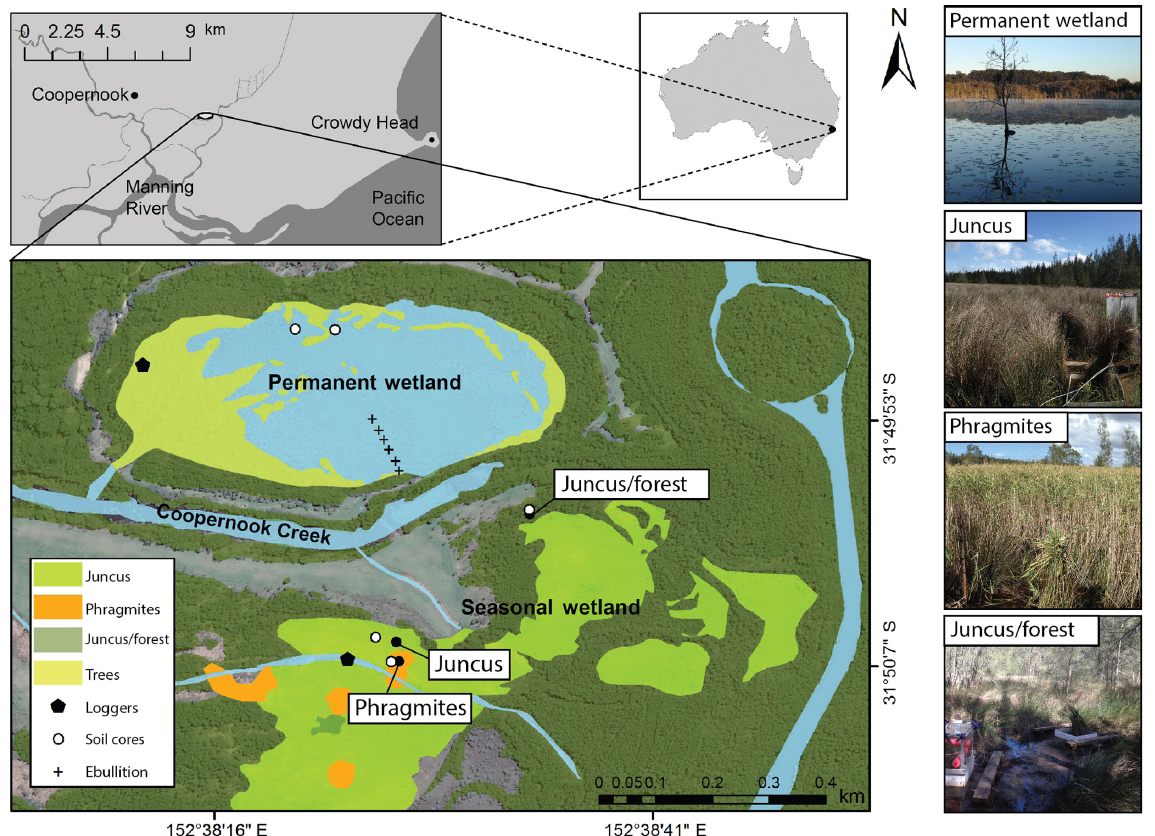
Figure 1. The seasonal wetland study sites consisting of Juncus ( Juncus kraussii ), Phragmites ( Phragmites australis ), and Juncus–forest ( Juncus kraussii below Casuarina spp.); the permanent wetland and sediment coring sites, ebullition replicate transect, 24h vegetation time series sites, and imagery of vegetation